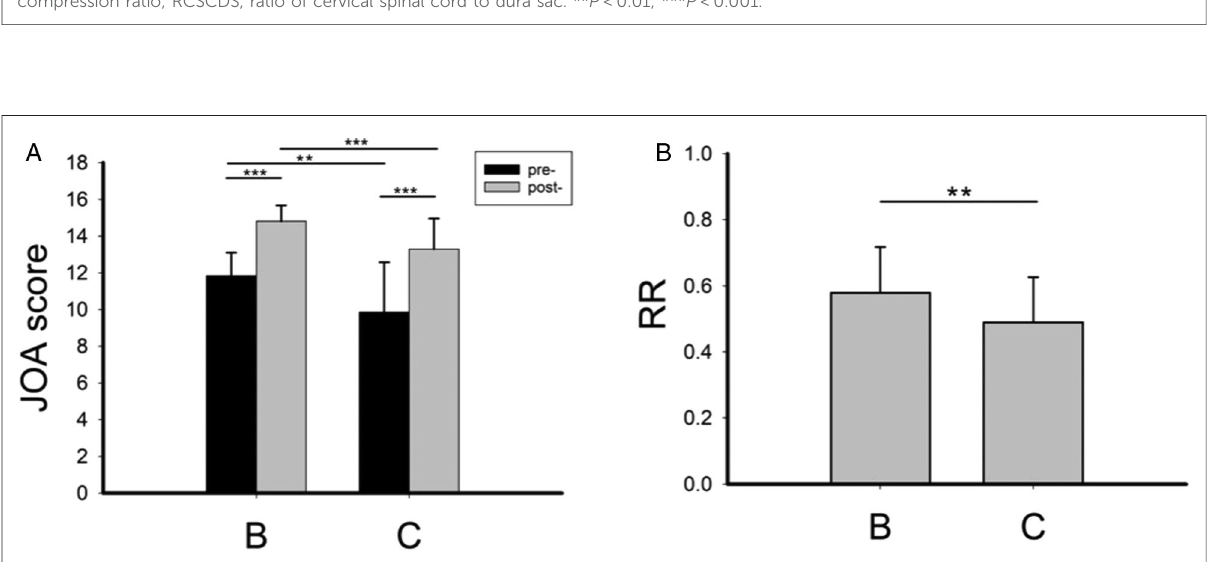
FIGURE 2 The spinal cord compression parameters of each group. MCC, maximum canal compromise; MSCC, maximum spinal cord compression; CR, compression ratio; RCSCDS, ratio of cervical spinal cord to dura sac. ** P <0.01; *** P <0.001.